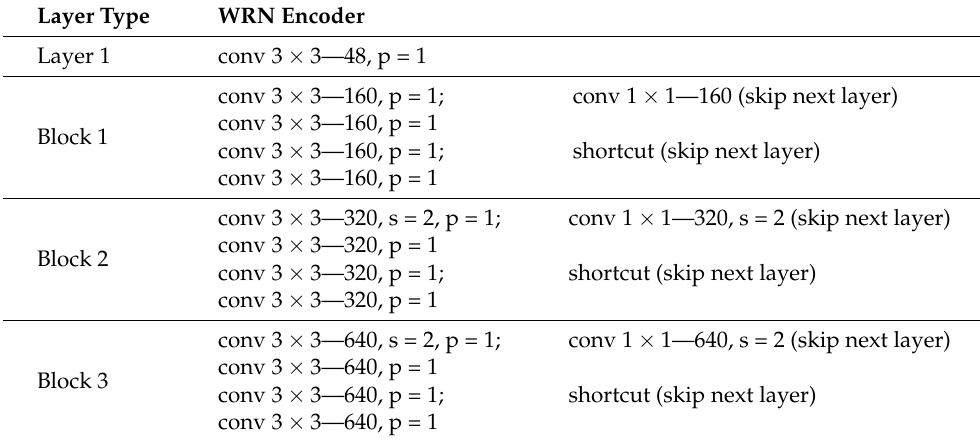
Table A3. A 14-layer wide residual network (WRN) encoder with a widen factor of 10. Convolutional layers (conv) are parametrized by a quadratic filter size followed by the amount of filters. p and s represent zero padding and stride, respectively. If no padding or stride is specified, then p = 0 and s = 1. Skip connections are an additional operation at a layer, with the layer to be skipped specified in brackets. Convolutional layers are followed by batch-normalization and a rectified linear unit (ReLU) activation. The probabilistic encoder ends on fully-connected layers for µ and σ that depend on the chosen latent space dimensionality and the data’s spatial size.